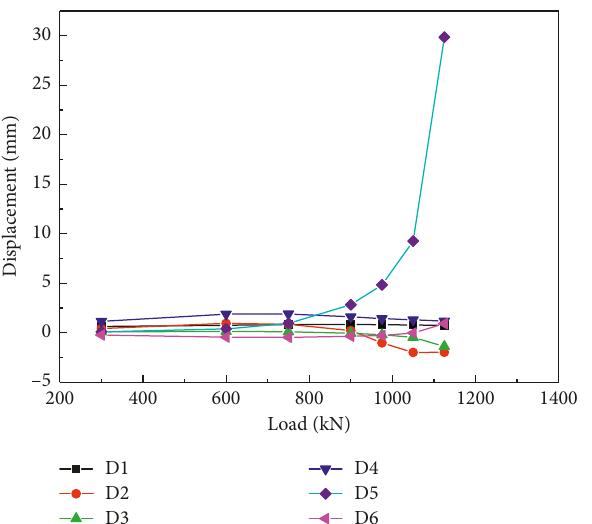
Figure 22: Load-displacement curves in Model 4.